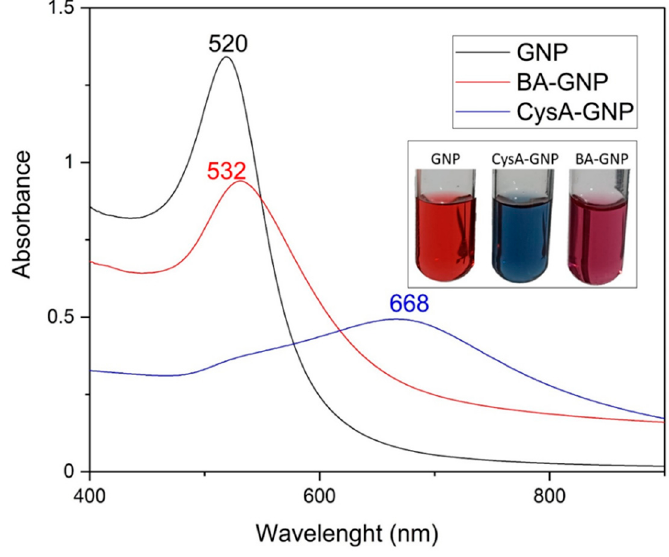
Figure 2. UV-VIS spectra and nanosuspension physical aspect of citrate-capped GNP, BA-GNP and the intermediate formed CysA-GNP.